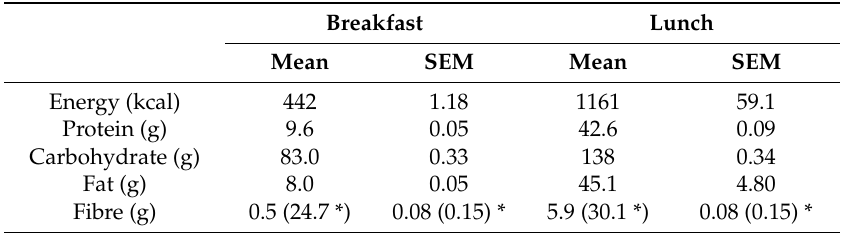
Table 2. Nutritional composition of the breakfast and lunch meals consumed on both study days. (Mean values with their standard errors (SEM) for ten